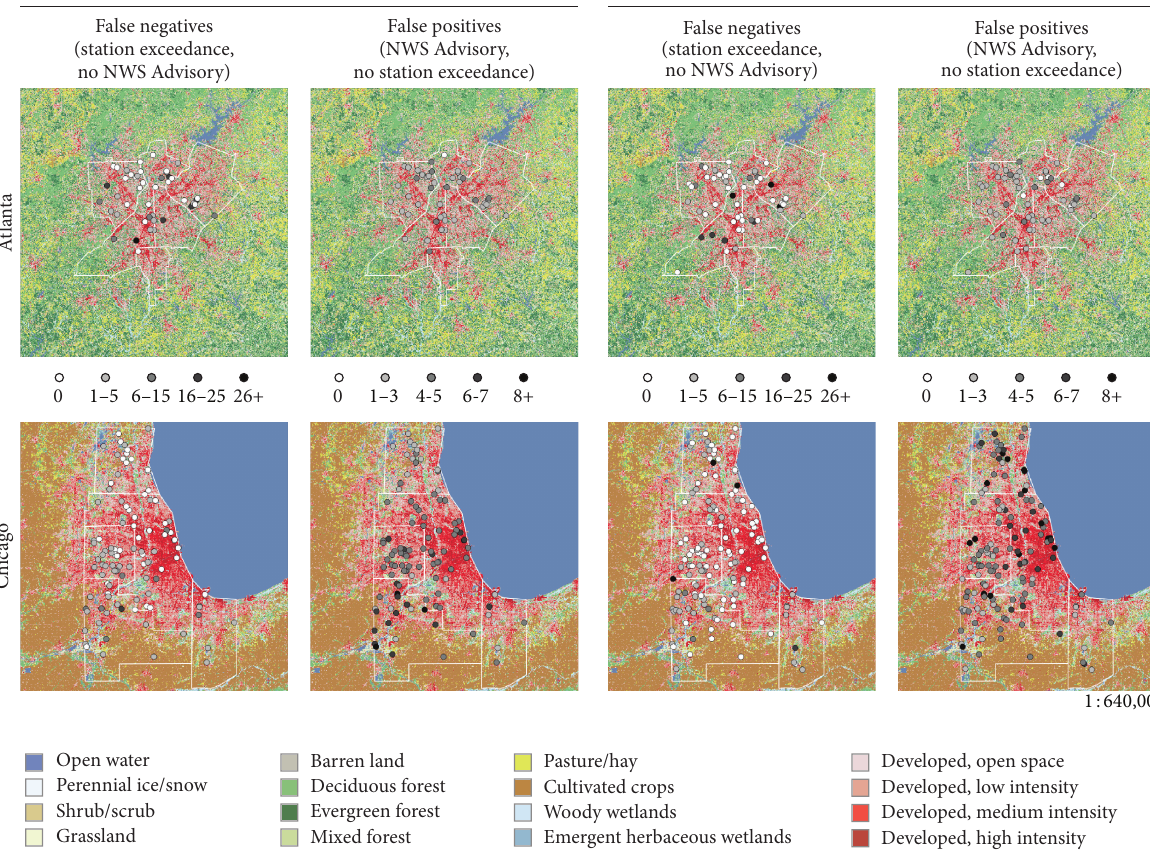
Figure 3: Stations are presented by the number of false positive and negative instances in 2011 and 2012. The National Land Cover Dataset’s (NLCD) 2011 land cover classification scheme is included. A false negative means station conditions exceeded Heat Advisory Criteria with no such Advisory issued from NWS. A false positive is when Heat Advisory conditions at the station were not met despite NWS issuing an